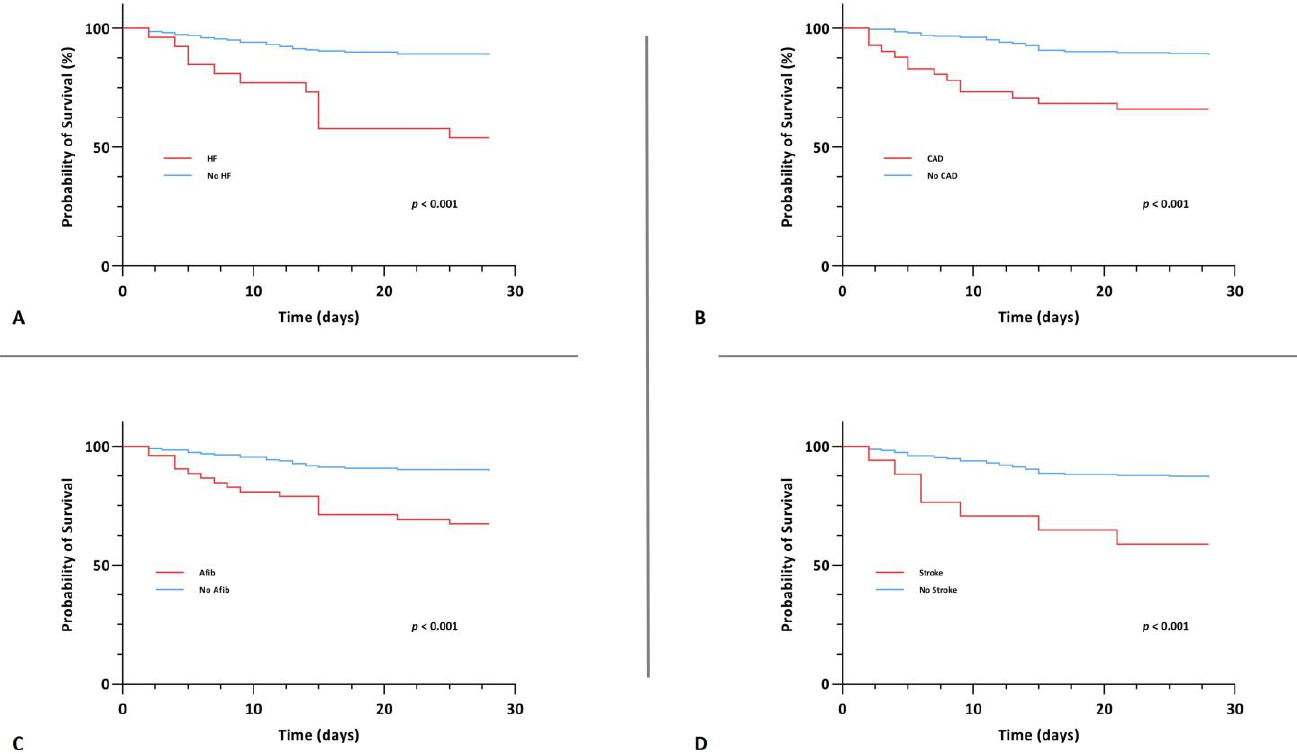
Figure 5. Kaplan-Meier survival curve for the primary endpoint of 28-day mortality stratified by coronary artery disease ( A ), heart failure ( B ), atrial fibrillation ( C ) and stroke ( D ).